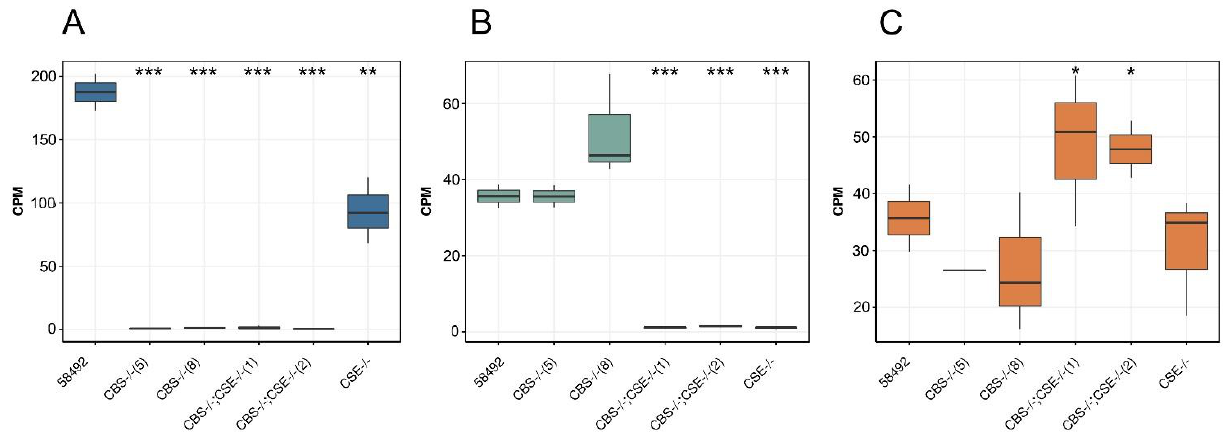
Figure 3. The expression of H 2 S producing genes in the heads of the males from the studied strains. ( А ) Box plot, demonstrating the expression levels of CBS in the heads of the flies from the studied strains. ( В ) Box plot, demonstrating the expression levels of CSE in the heads of the flies from the studied strains. ( C ) Boxplot, demonstrating the expression levels of MST in the heads of the flies from the studied strains. (* represents p < 0.05, ** represents p < 0.005, and *** denotes FDR < 0.001).